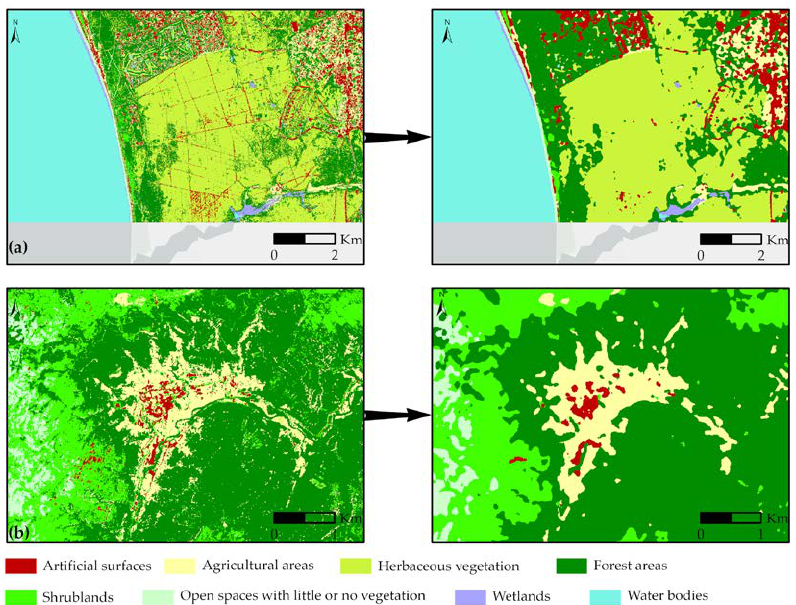
Figure 13. The figures on right side show the effect of the generalization obtained with the application of the majority filter to the images on left side, for two regions located, respectively, in: ( a ) Study area A and ( b ) study area B.